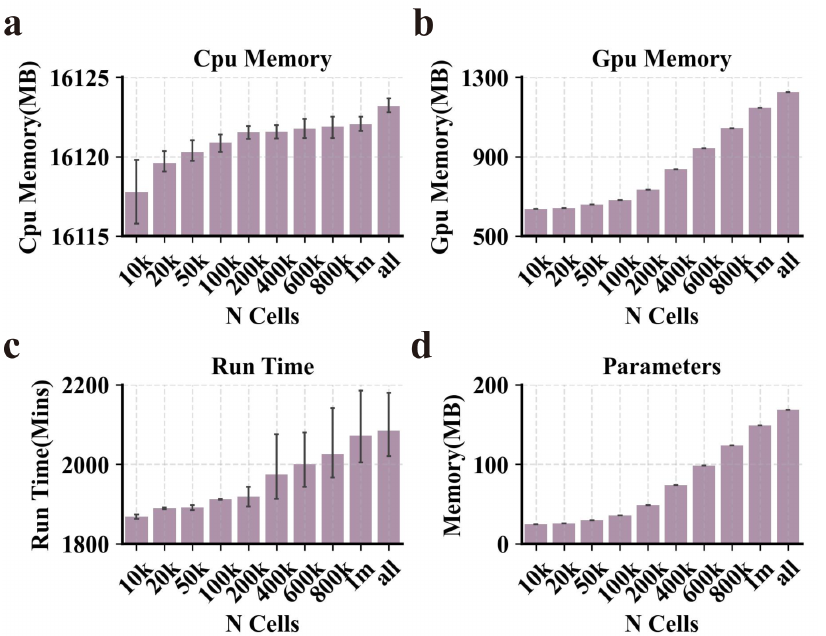
Figure 7. Performance of PROTRAIT in large-scale scATAC-seq analysis. ( a – d ) The runtime, peak CPU memory usage, peak GPU memory usage, and parameter of PROTRAIT on sciATAC human atlas. To remove fluctuations from random sampling, we employ a cross-validation strategy and repeat the down-sampling 10 times to obtain